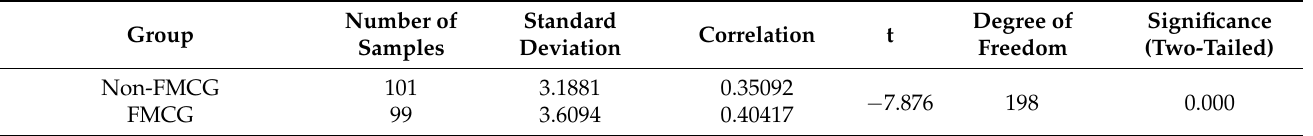
Table 9. The impact of different promotional product types in time-limited promotions on upward anticipated regret. Group